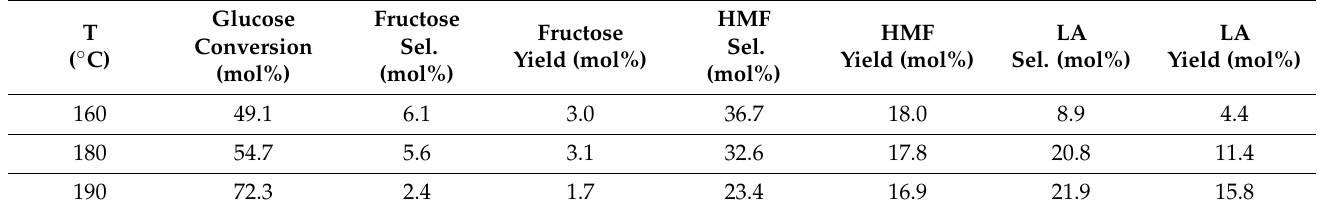
Table 5. MW-assisted conversion of glucose in the presence of ZrPO catalyst at 180 and 190 ◦